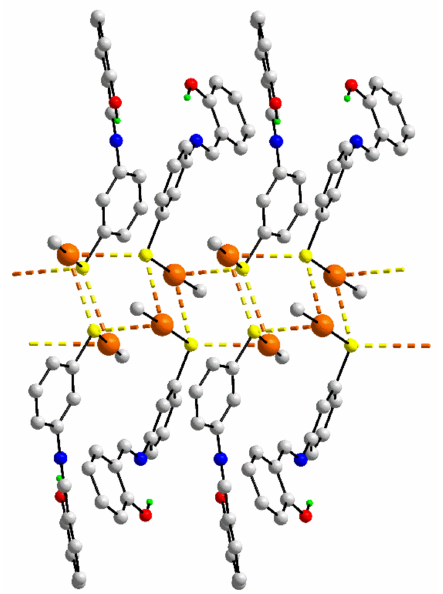
Figure 22. Supramolecular association in the crystal of 58 , having a square-wave arrangement of Hg ··· S interactions within the one-dimensional